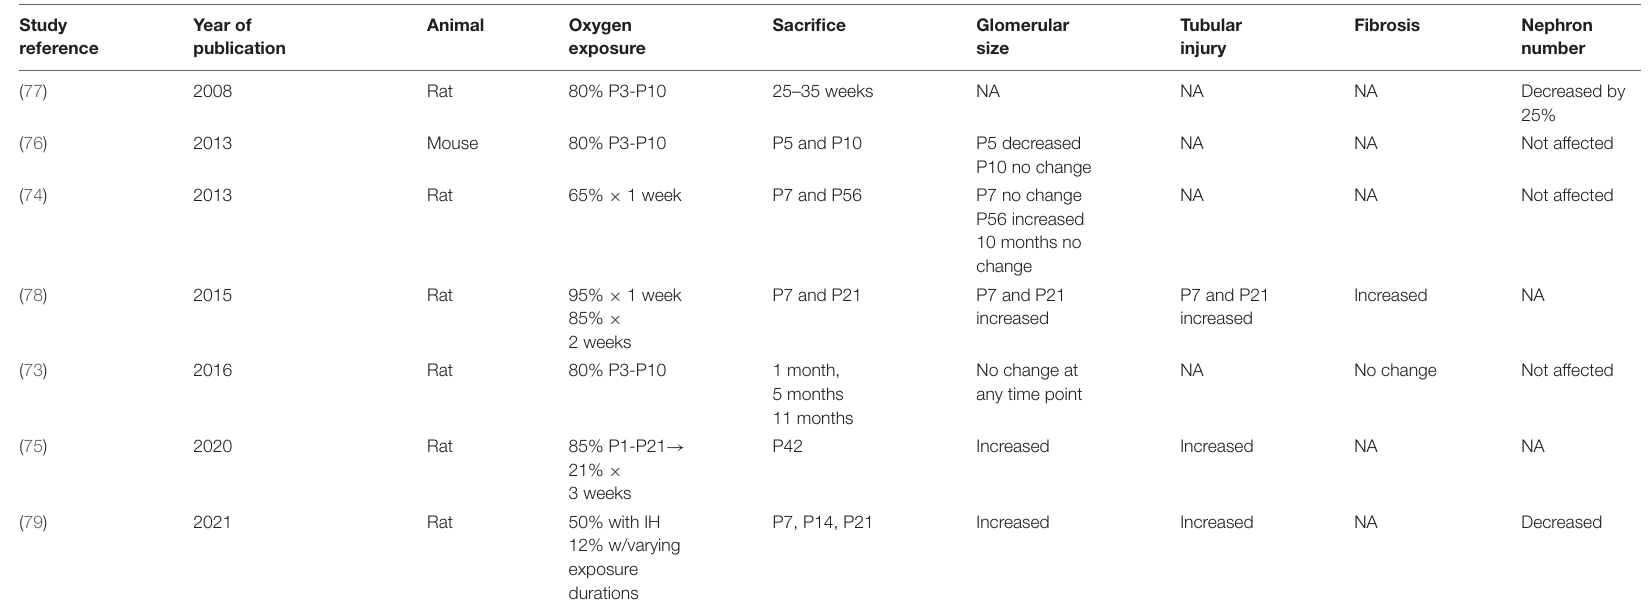
TABLE 1 | Rodent studies of hyperoxia and/or hypoxia related renal injury during postnatal nephrogenesis. Study